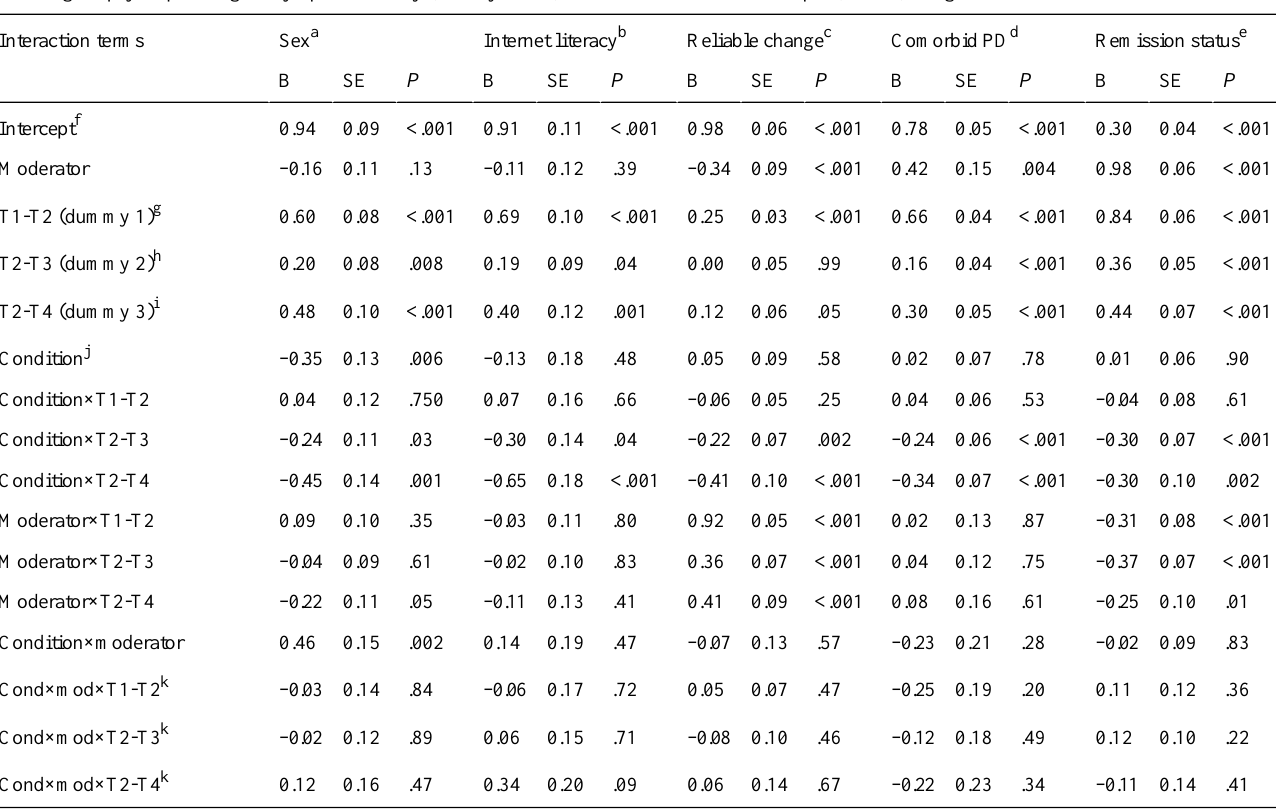
Table 3. Multilevel results of the interactions between pretreatment participant characteristics (dichotomic moderator variables), intervention condition, and change in psychopathological symptom severity (dummy coded) for the intention-to-treat sample (N=400) using full maximum likelihood